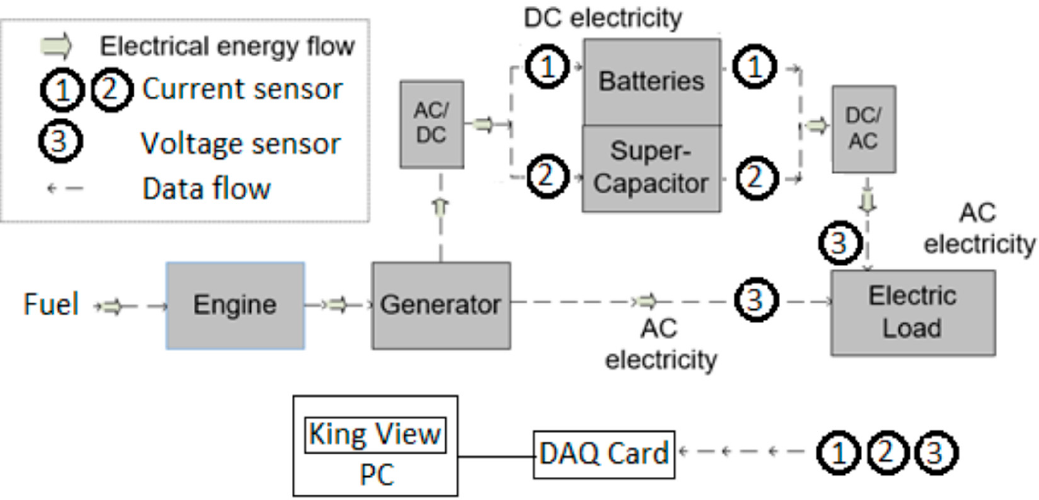
Figure 1. Schematic diagram of the experimental test rig of distributed power generation system with energy storage system.